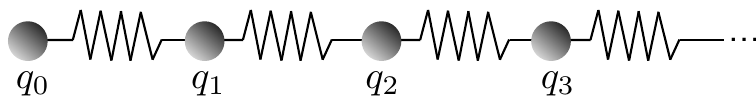
Figure 3 . A simple graphic depiction of a half-infinite Toda chain for the evolution of extremal correlators q ’s. Each site can be thought of as an oscillator connected to a neighboring site by a i spring. The interaction between each site is governed by the right-hand side of equation (2.30), while the second equation (2.31) sets the boundary condition for the